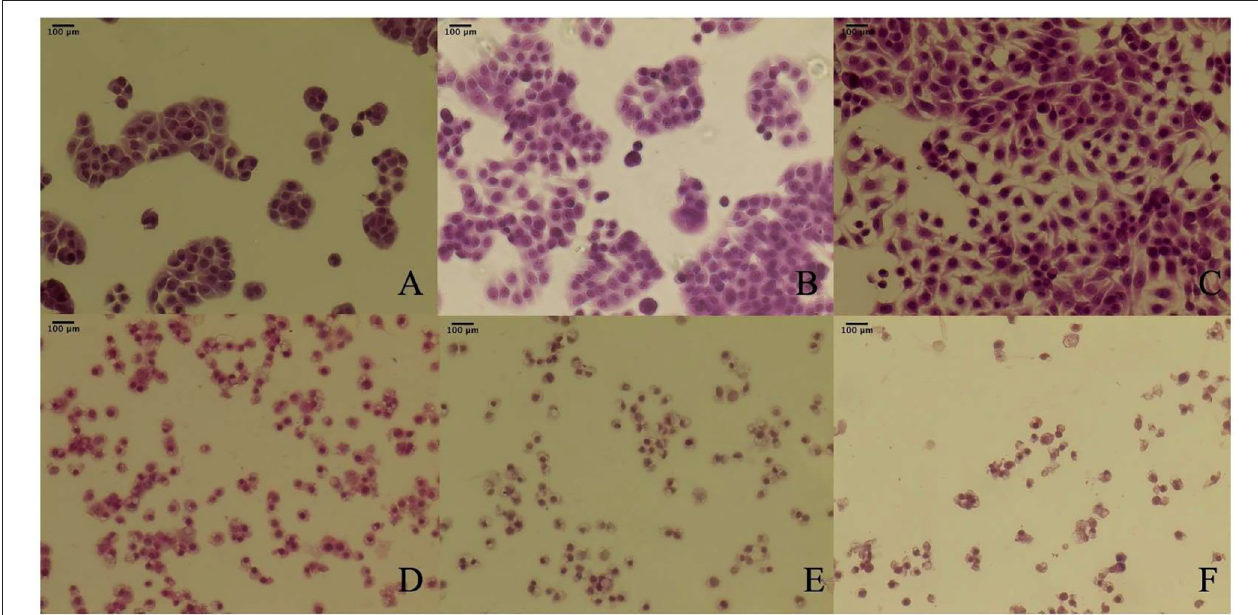
FIGURE 7 | Effect of TBs-E on HT-29 cell morphology (200X); (A) control (24h), (B) control (48h), (C) control (72h), (D) TBs-E treatment (24h), (E) TBs-E treatment (48h), and (F) TBs-E treatment (72h).